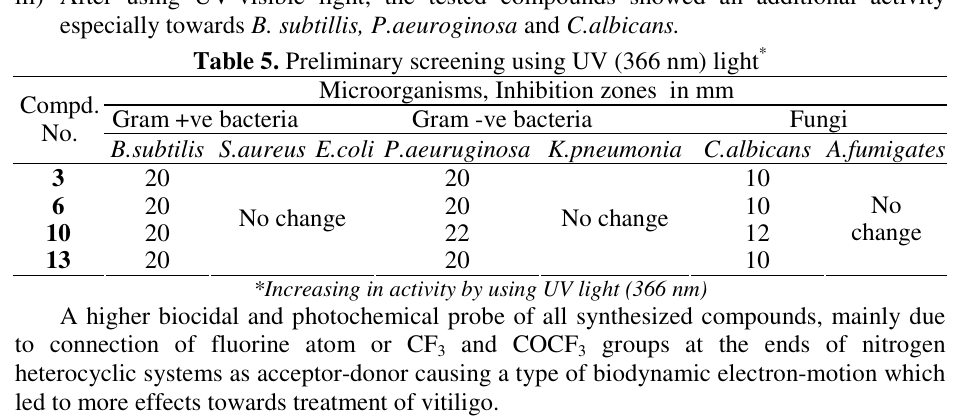
Table 5. Preliminary screening using UV (366 nm) light * Microorganisms, Inhibition zones in mm Compd. Gram +ve bacteria Gram -ve bacteria Fungi No.